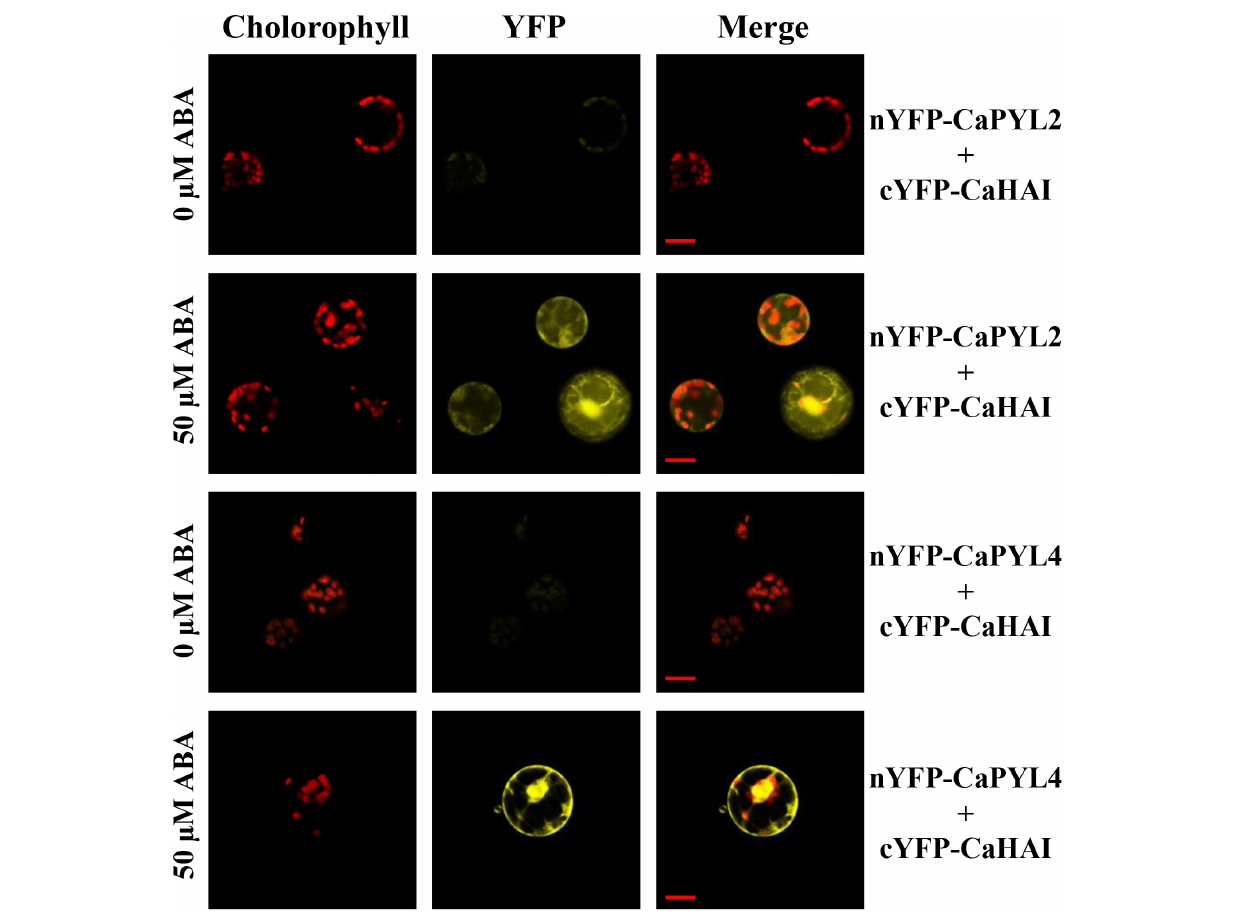
FIGURE 6 | BiFC assay in Nicotiana tabacum protoplasts. CaHAI fused with the C-terminus of YFP (cYFP) was cotransformed into protoplasts, respectively, with CaPYL2 and CaPYL4 fused with N-terminus of YFP. Chlorophyll autofluorescence, YFP fluorescence and merged images are shown in the presence or absence of ABA. Scale bars = 20 µ m in all